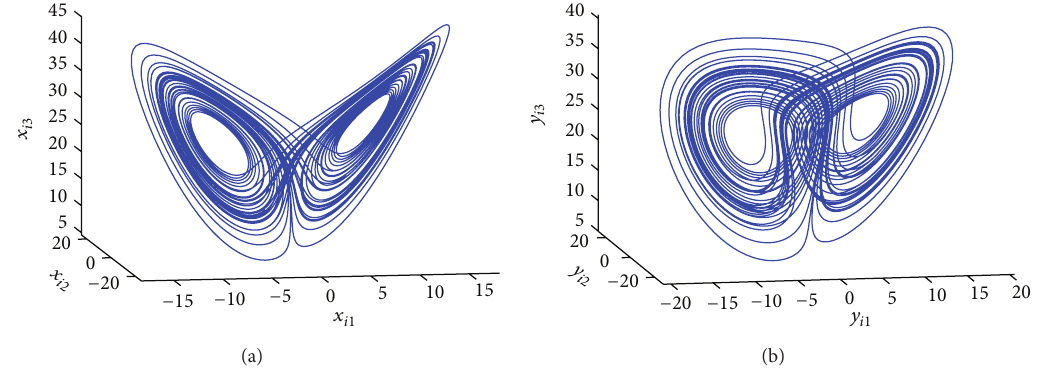
Figure 11: Phase diagrams of node 3 in the drive network (a) and response network